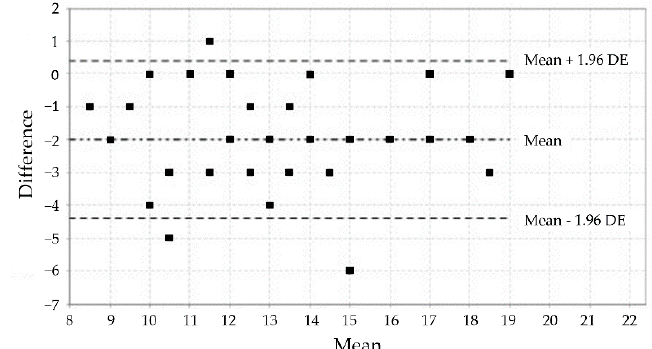
Figure 2. Bland–Altman plot of the external visual subscale of the MIQ-3.